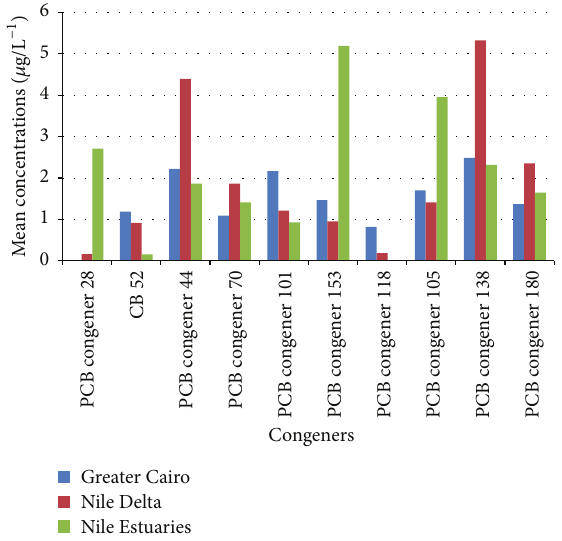
Figure 2: Mean PCB congener concentrations in waters from the different sampling regions.